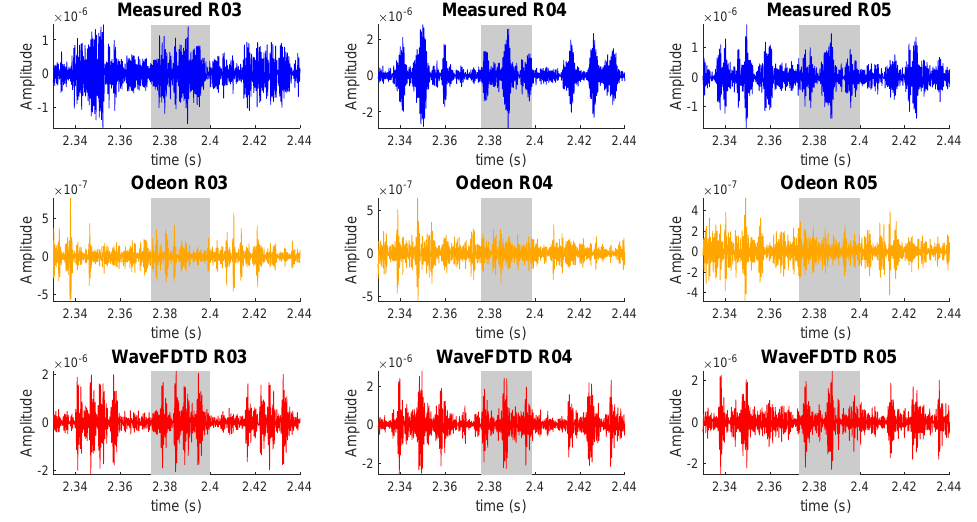
Figure 15. Structure of triplet pattern measured for the original room configuration on the aisle for three different receiver heights. R03 is located at a height of 1m, R04 at 1.5m and R05 at 2m. Highlighted area demonstrates the compression of the triplet for receiver R04 (height near source